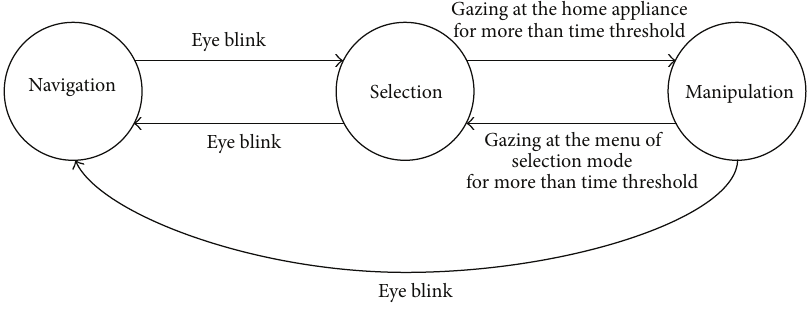
Figure 25: Overall process of transitions between the three modes.